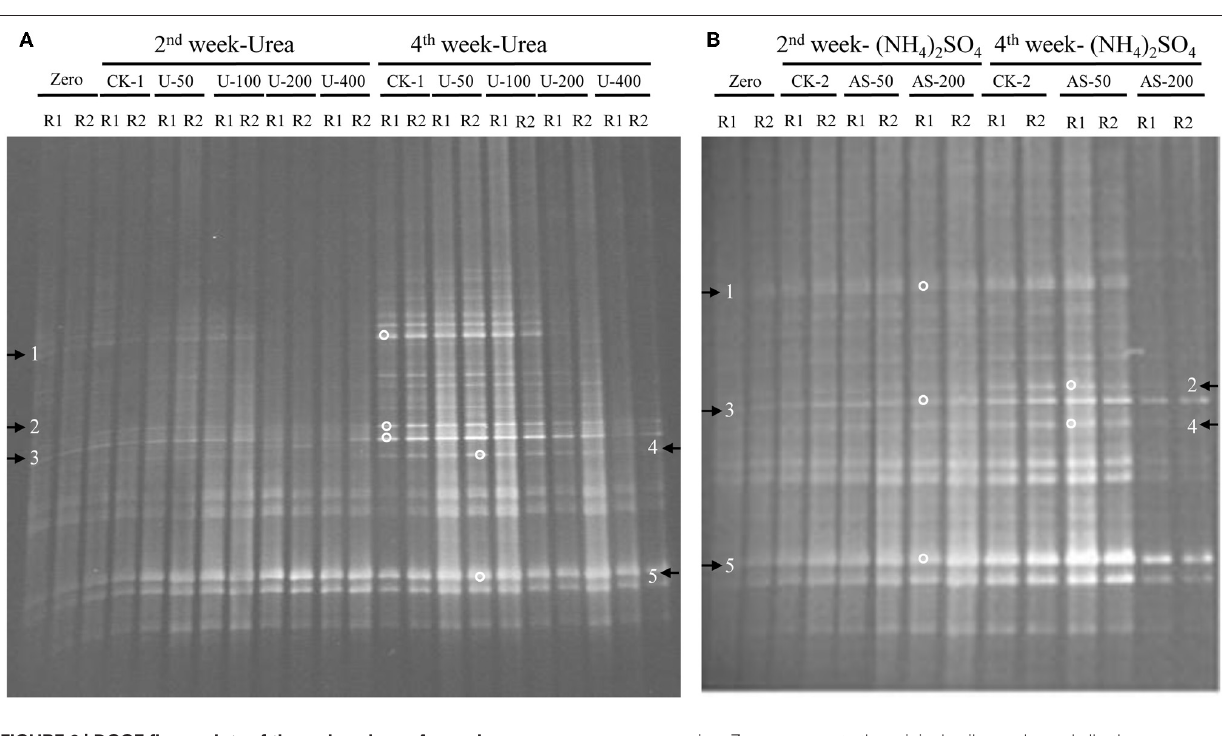
sequencing. Zero represents the original soil sample, and all other designations are the same as those in Figure 1 . R1 and R2 represent duplicate